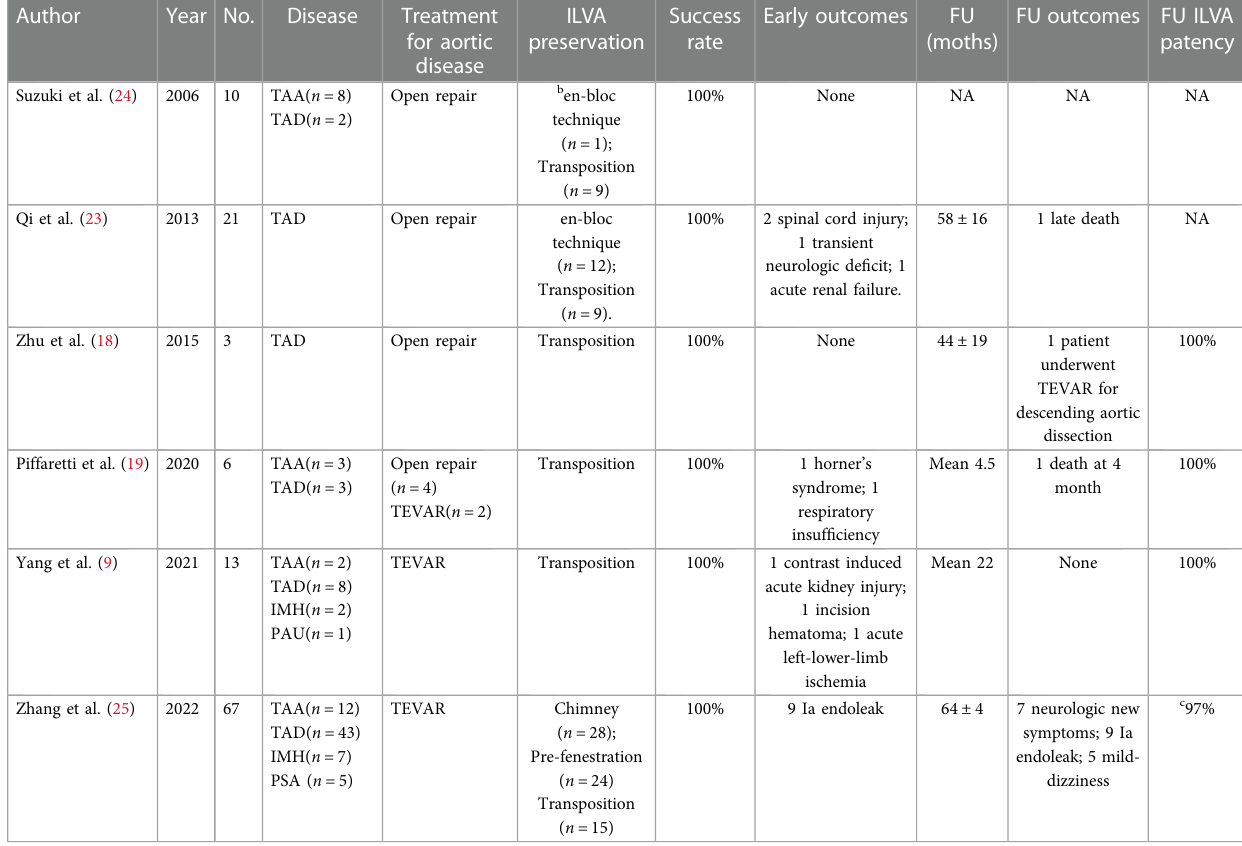
TABLE 4 Techniques for preservation of isolated left vertebral artery: Literature summary a .